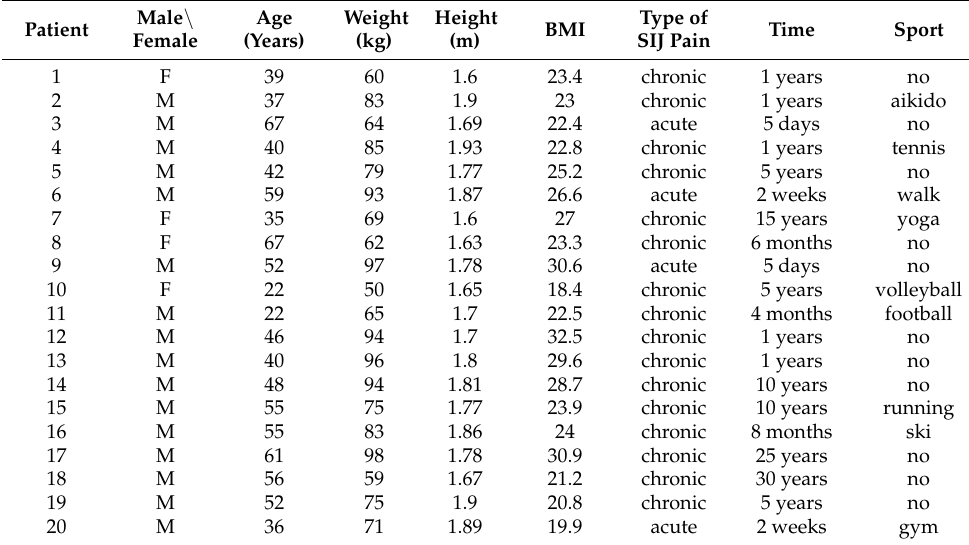
Table 1. Descriptive data of the patients.